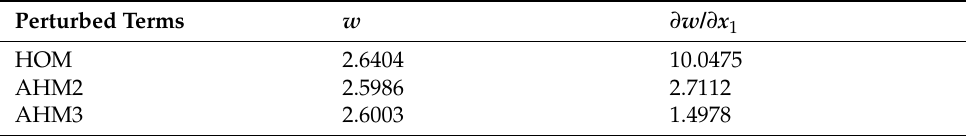
Table 5. DRSS for the CFCF periodic layered plate.